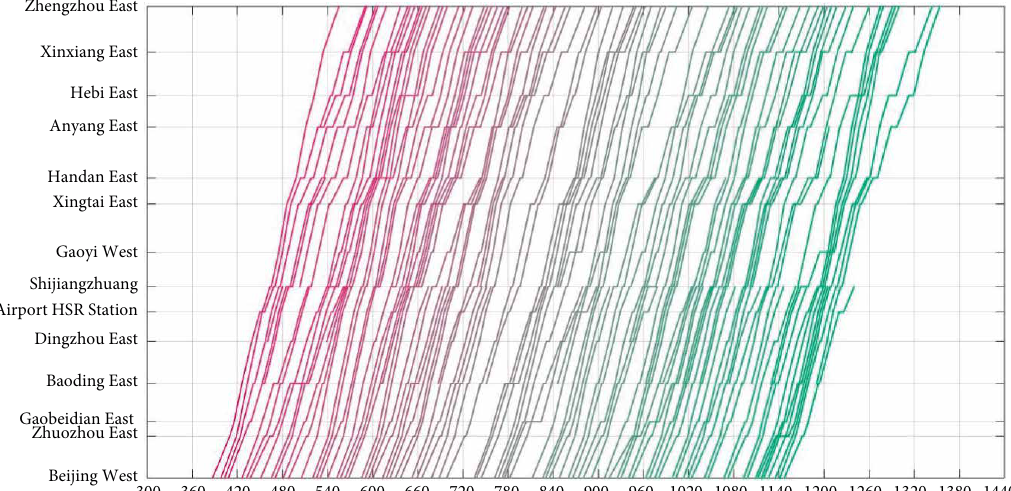
Figure 9: The adjusted